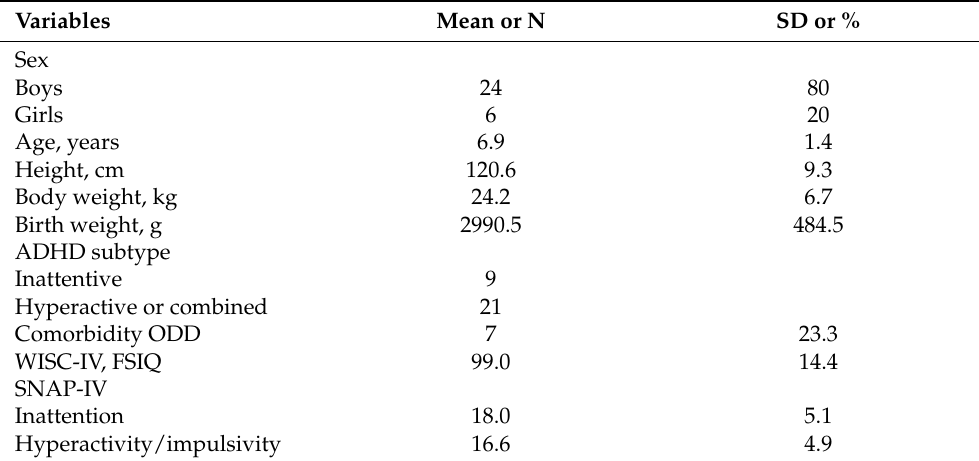
Table 1. Characteristics at baseline among ADHD patients (N = 30) who received 8-week probi- otic therapy.